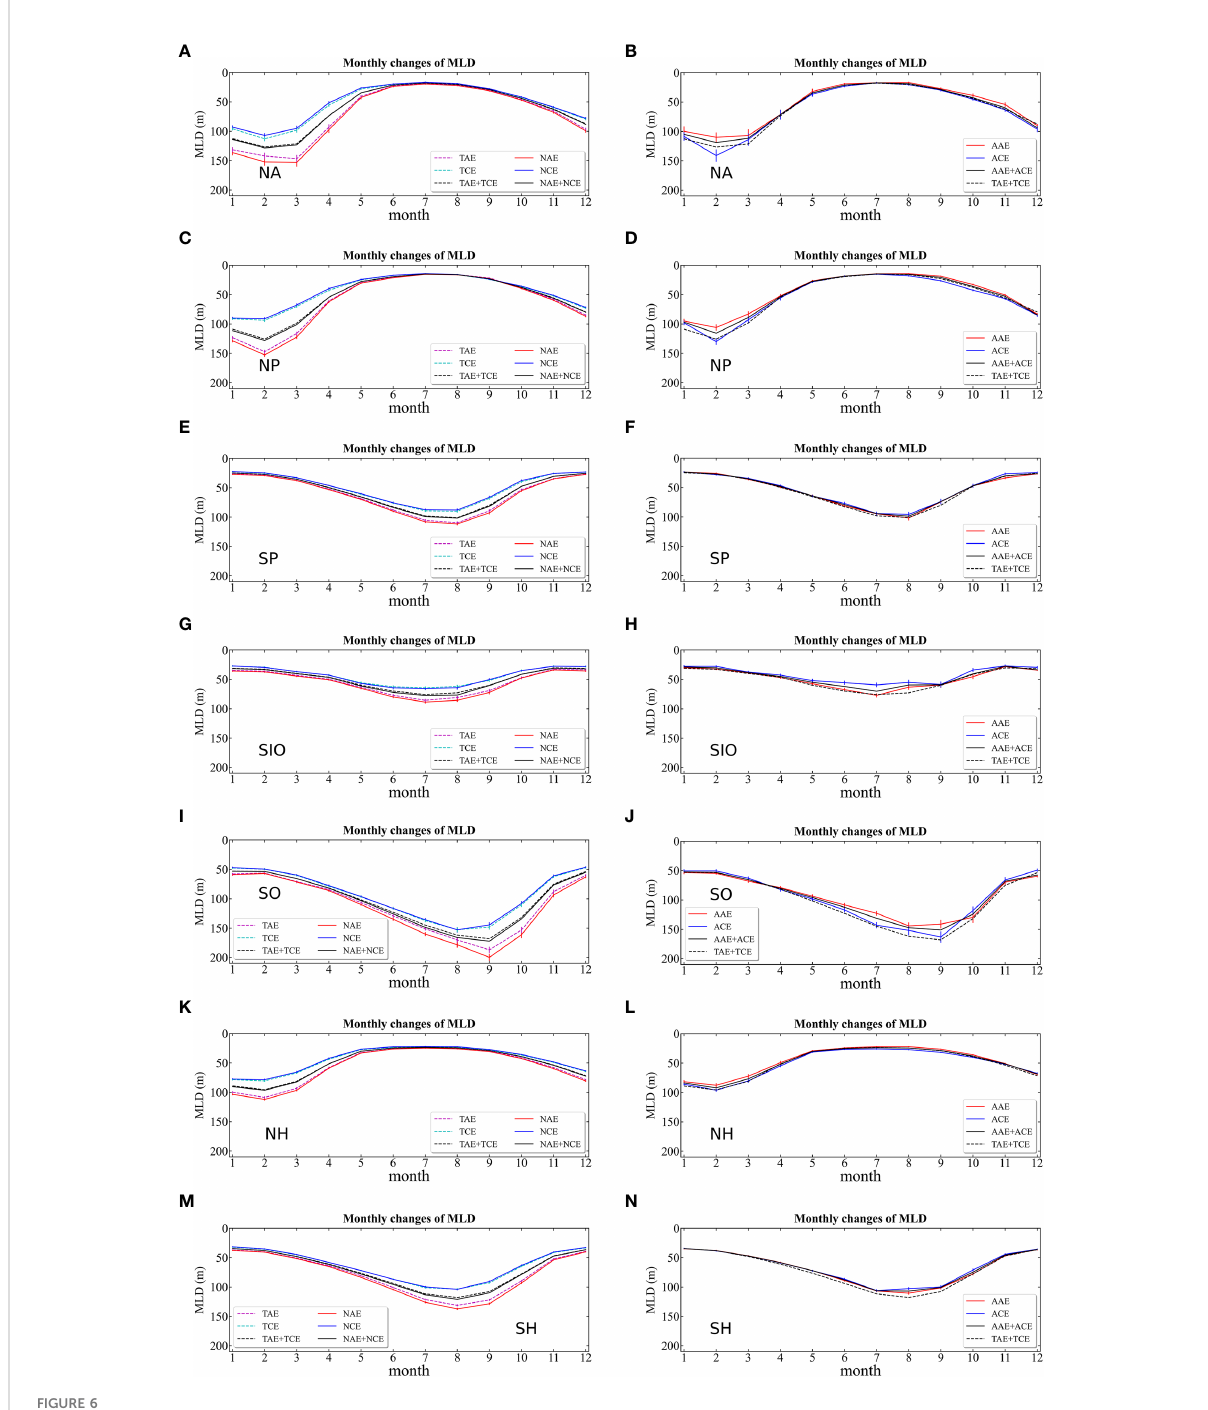
FIGURE 6 Seasonal cycle of mixed layer depth (MLD) in NA (A, B) , NP (C, D) , SP (E, F) , SIO (G, H) , SO (I, J) , NH (northern hemisphere) (K, L) and SH (southern hemisphere) (M, N) . The solid (dashed) red (magenta) line and solid (dashed) blue (cyan) line represent NAE (TAE) and NCE (TCE) and the solid (dashed) black line indicates the sum of NAE (TAE) and NCE (TCE) in left panels. The solid red (blue) line and solid (dashed) black line in the right panels indicates AAE (ACE) and the sum of AAE (TAE) and ACE (TCE), respectively. The standard error, computed as s = the standard deviation of all MLD observations during each calendar month and N is the number of MLD observations in each month, is indicated by the vertical